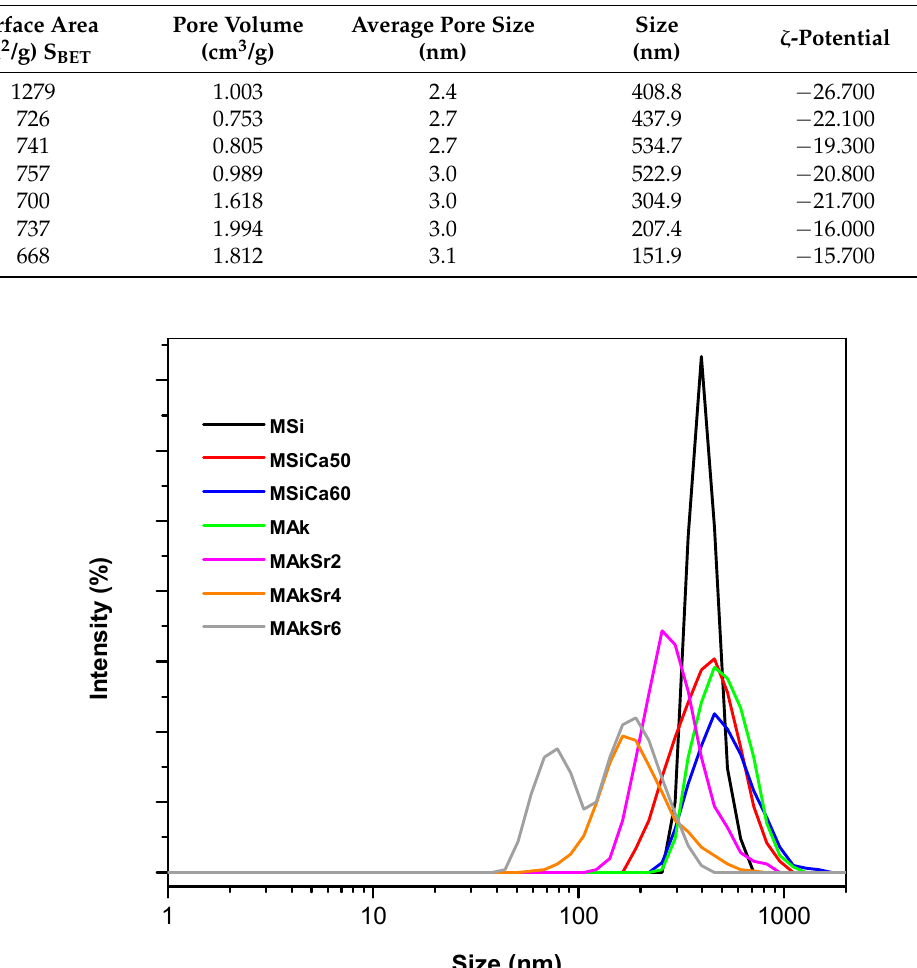
Table 1. Textural properties of the synthesized mesoporous silica-based nanoparticles (MSNs). Silica-Based Mesoporous Nanoparticles (MSNs), mol%